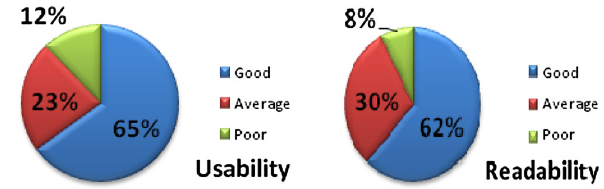
Fig. 7 Usability and readability